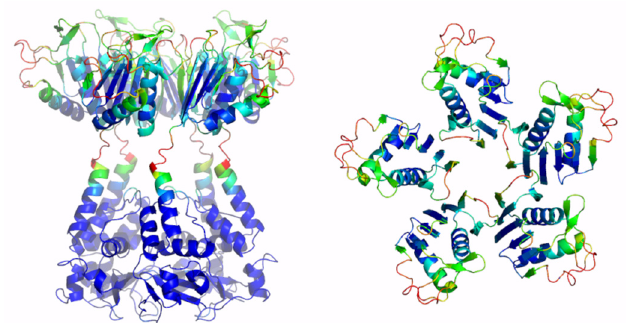
Figure 5. Schematic representation of AF full-length KCTD4. Two views are shown (on the left, the full-length pentameric assembly; on the right, the CTD domains only). The structural model is colored following AF per-residue confidence metric (pLDDT).